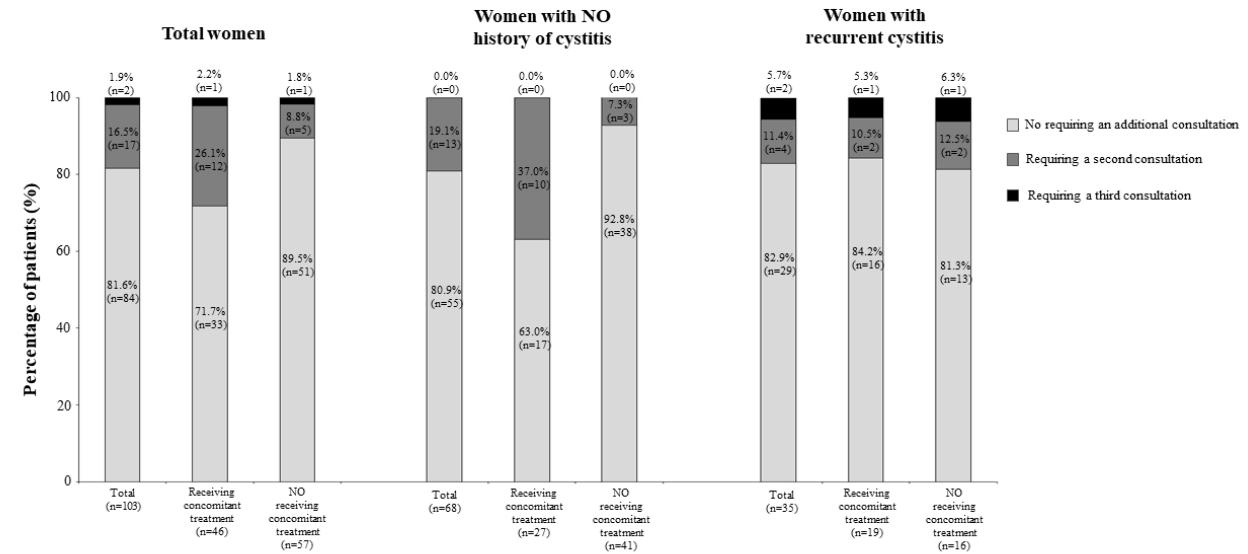
Figure 1. Women requiring additional consultations for the management of